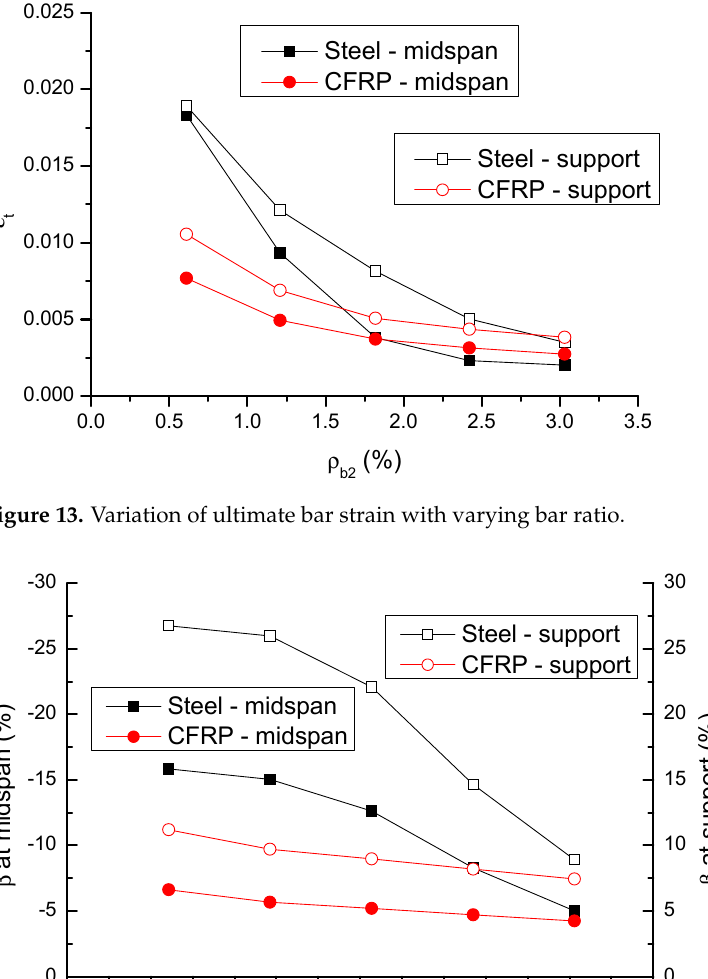
Figure 15. β – ε t relationship. 0.000